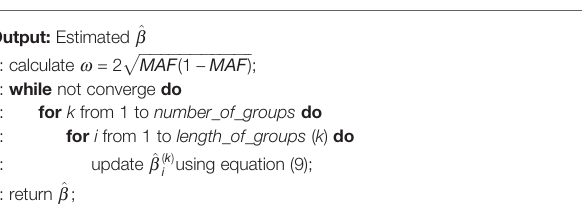
ALGORITHM 1 | Parameter estimation for weighted sparse group